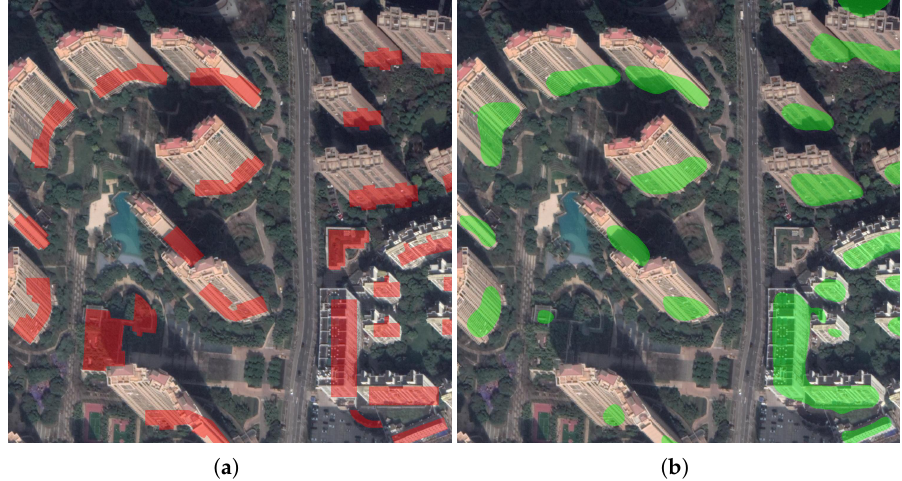
Figure 13. Samples from the city of Shanghai. This sample is cropped from Figures 11g,h. The figure of ( a ) is the label of the sample, and the figure of ( b ) is the prediction results. All the samples are with a size of 1500 ×